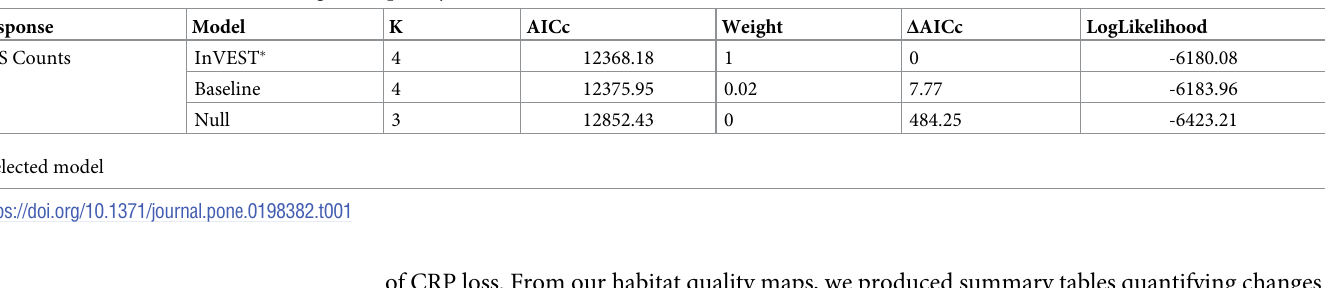
Table 1. Results of model selection among intercept-only, baseline-habitat score, and InVEST habitat-score